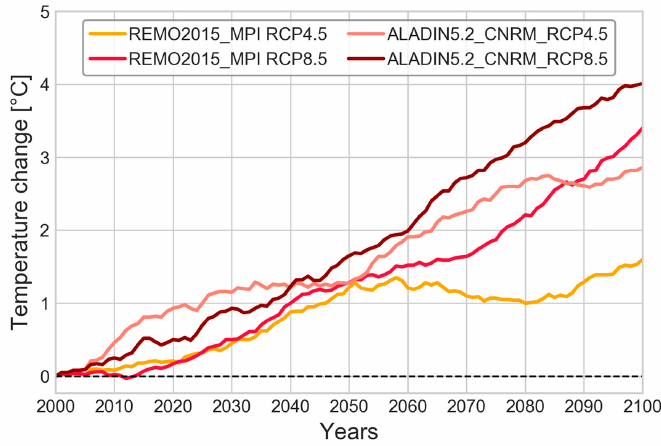
Figure 10. Temporal evolution of the change in the annual mean temperature over Hungary in 2000–2100 based on the ALADIN5.2 and REMO2015 simulations, smoothed with the moving average of a 30-year window. Reference period: 1971–2000.